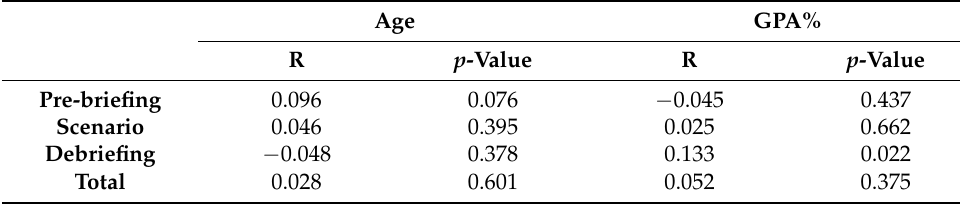
Table 5. The correlation between Age, GPA% and all Domains ( n =